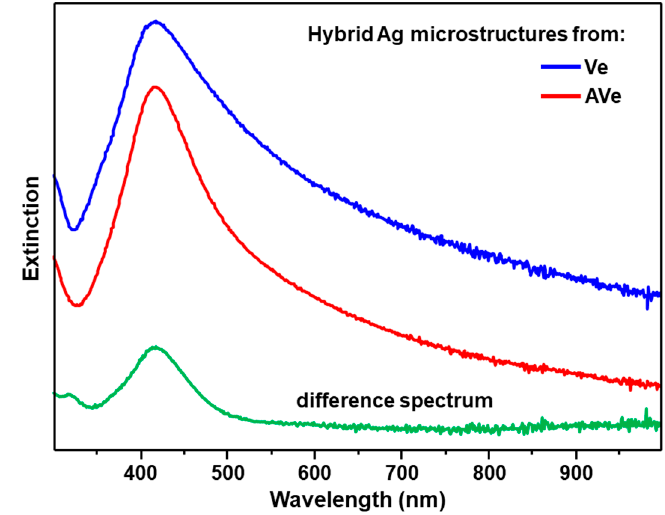
Figure 3. Extinction spectra of hybrid Ag microstructures from Ve (blue curve) and AVe (red curve). Green curve is the difference spectrum obtained by subtracting the blue spectrum from the red one.